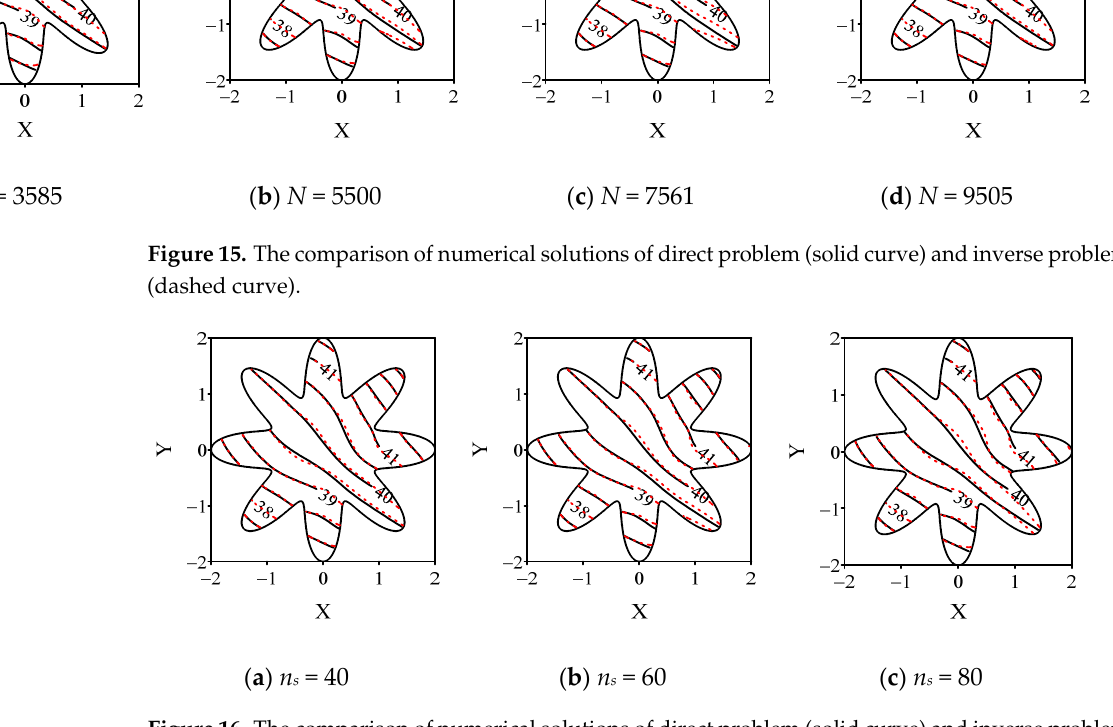
u in Step 2 (dashed lines) and 2